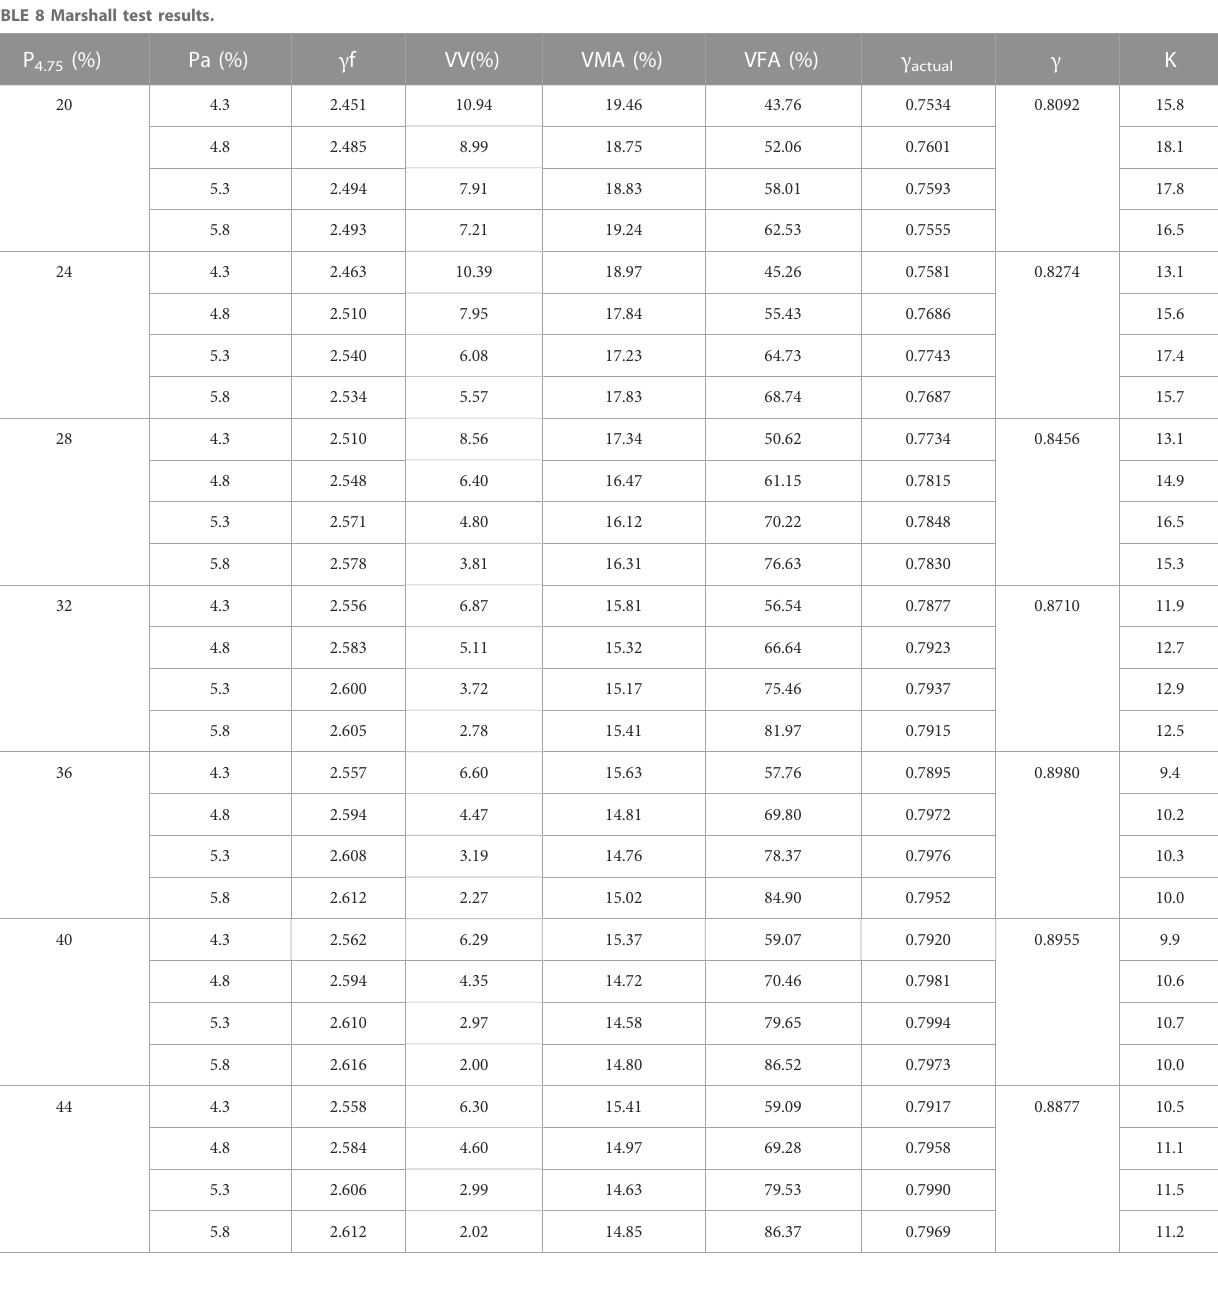
TABLE 8 Marshall test